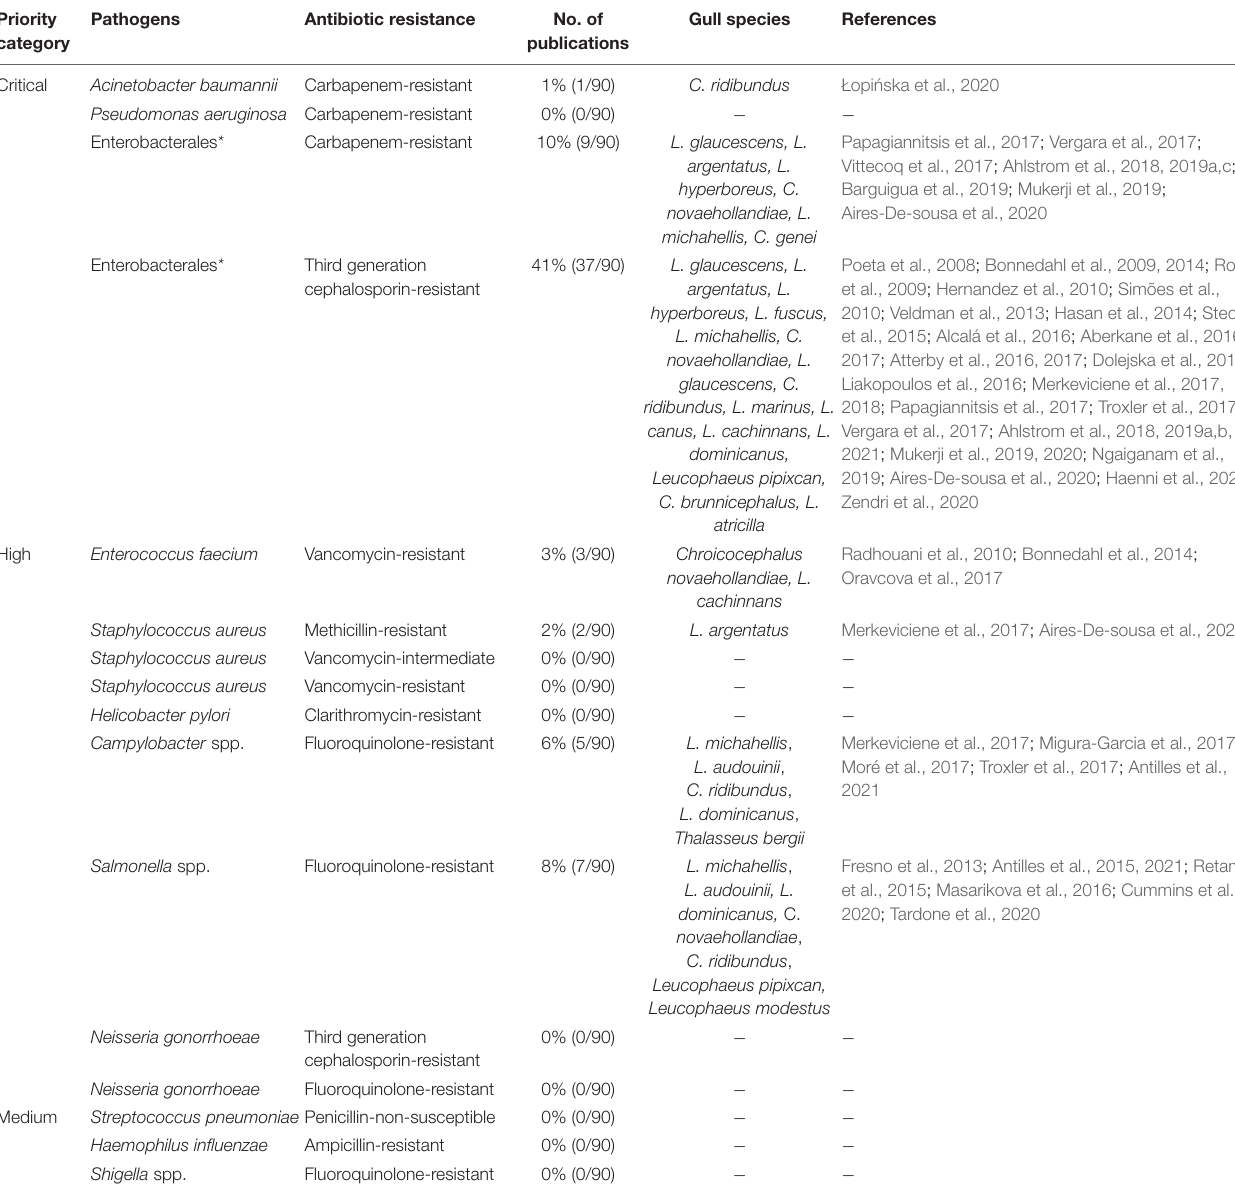
TABLE 2 | ARB of the “Global Priority Pathogens” list of the World Health Organization isolated from gulls reported between 1981 and